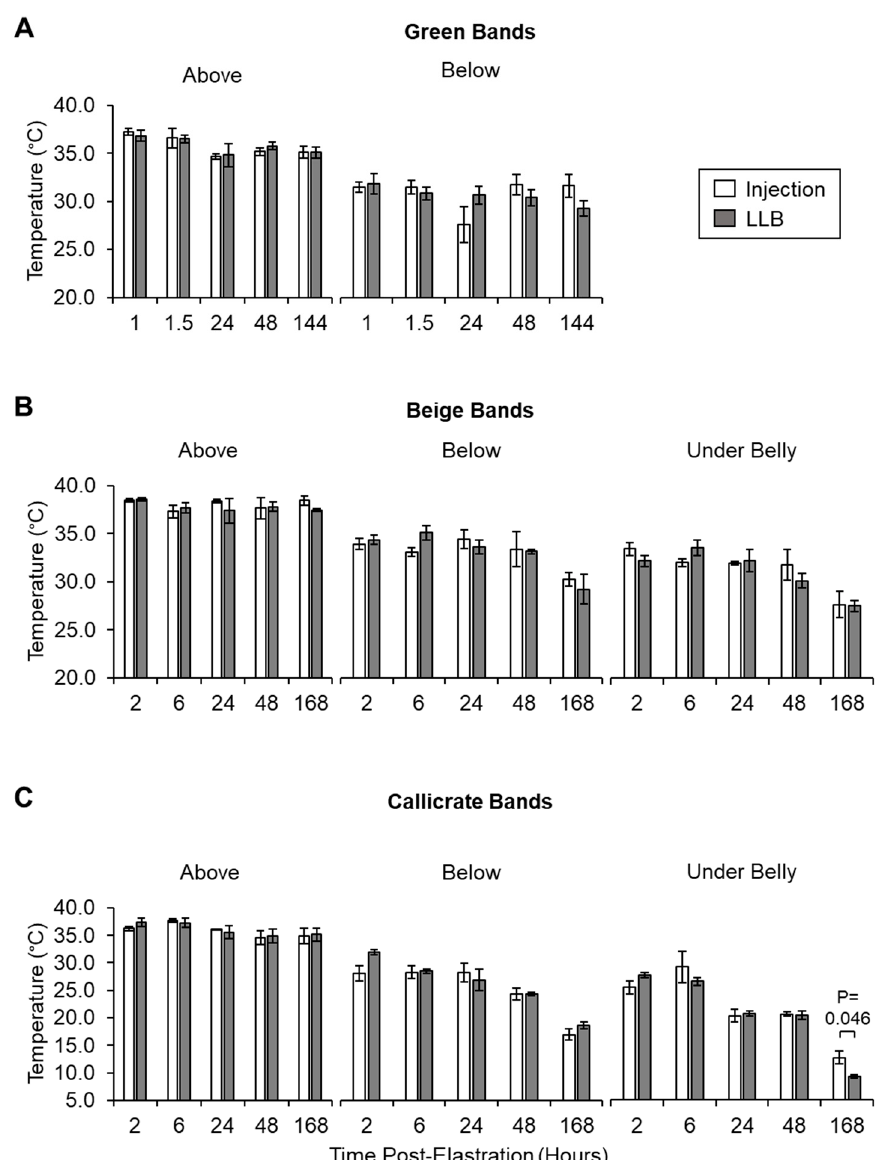
Figure 7. Scrotal temperatures of control and treatment calves above and below castration band placement over time. Scrotal temperature above and below the green ( A ), beige ( B ), and Callicrate TM ( C ) castration bands were plotted against the duration of band placement for test (LLB) and control (injection) animals. The temperature of the animal’s belly was also measured for the animals treated with beige ( B ) and Callicrate TM ( C ) bands. Bars represent the mean ± standard error of the mean (SEM) for three independent replicates per time point. Statistical significance was determined using an unpaired, two-tailed t -test. Data were assessed for normality using a Shapiro–Wilk test. The cutoff for significance was p < 0.05.